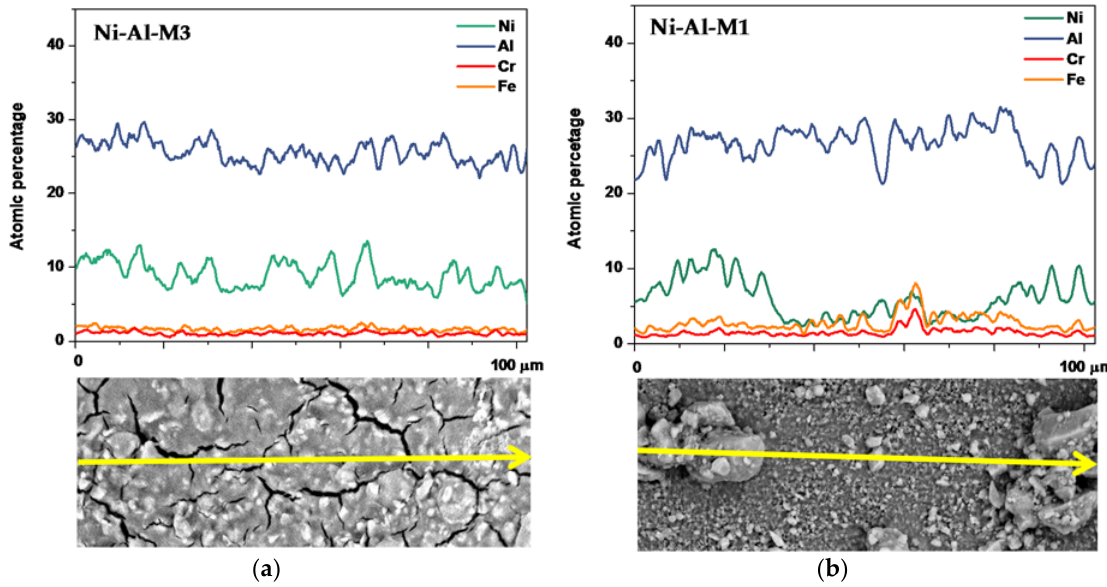
Figure 4. Linear mappings applied to ( a ) Ni-Al-M3 and ( b ) Ni-Al-M1 catalytic systems in the intermediate area of the valley.